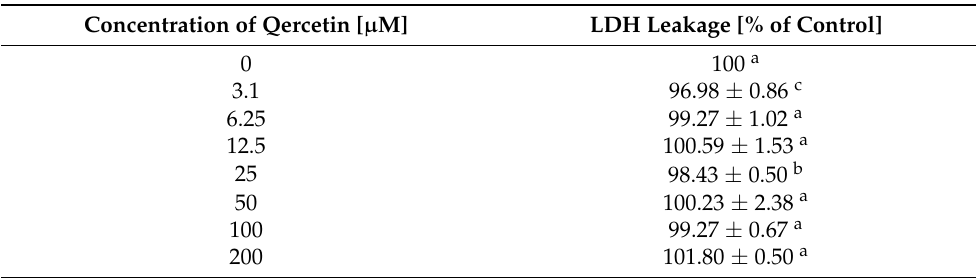
Figure 2. The effect of quercetin on SK-N-SH cells exposed to H 2 O 2 was measured by the degree of lipid peroxidation (concentration of MDA) ( a ) and LDH release ( b ). The cells were pretreated for 24 h with selected quercetin concentrations (6.25; 25; 100; 200 µ M), followed by 3 h contact with H 2 O 2 (3–5 mM). Percentage of LDH leakage was referred to values obtained for cells treated with H 2 O 2 only ( b ). Values represent mean ± SD of three to six independent experiments. Different letters indicate significant differences ( p ≤ 0.05). Table 1. LDH leakage in SK-N-SH cells treated for 24 h with various concentrations of quercetin (3.1–200 µ M). Dehydrogenase lactate release in control untreated cells was defined as 100%. Values represent mean ± SD of three to six independent experiments. Different letters indicate significant differences ( p ≤